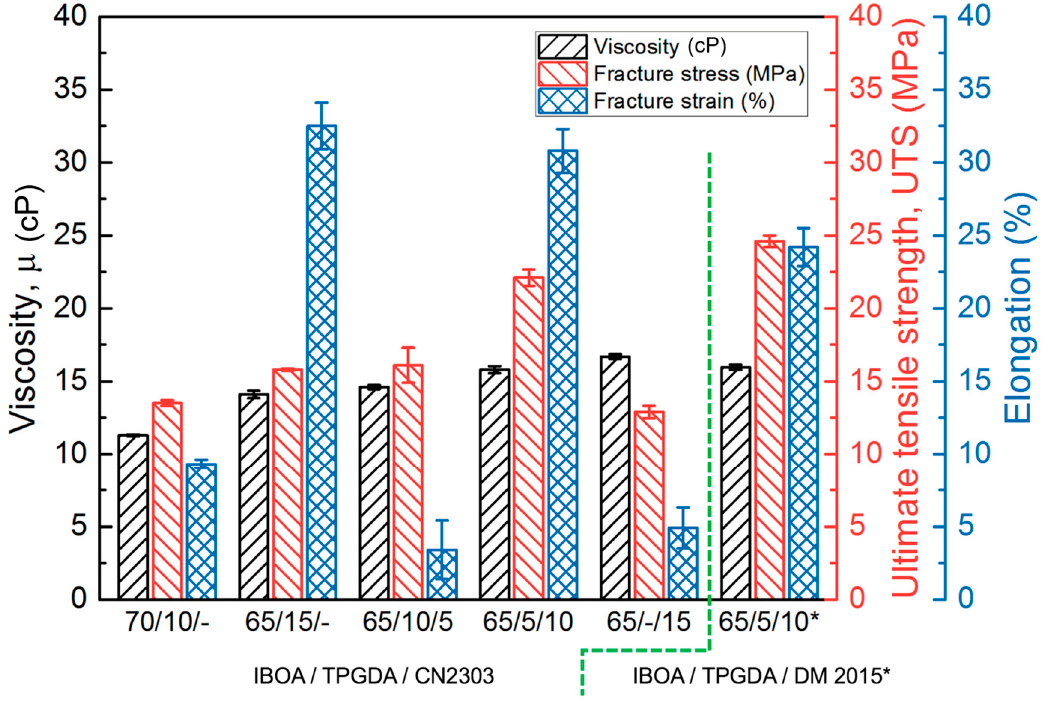
Figure 4. The effects of substitutions of the crosslinkers (TPGDA, CN2303, and DM 2015) for the Figure 4. The e ff ects of substitutions of the crosslinkers (TPGDA, CN2303, and DM 2015) for the monomer (IBOA) on the physical and mechanical properties of the prepared resin. monomer (IBOA) on the physical and mechanical properties of the prepared